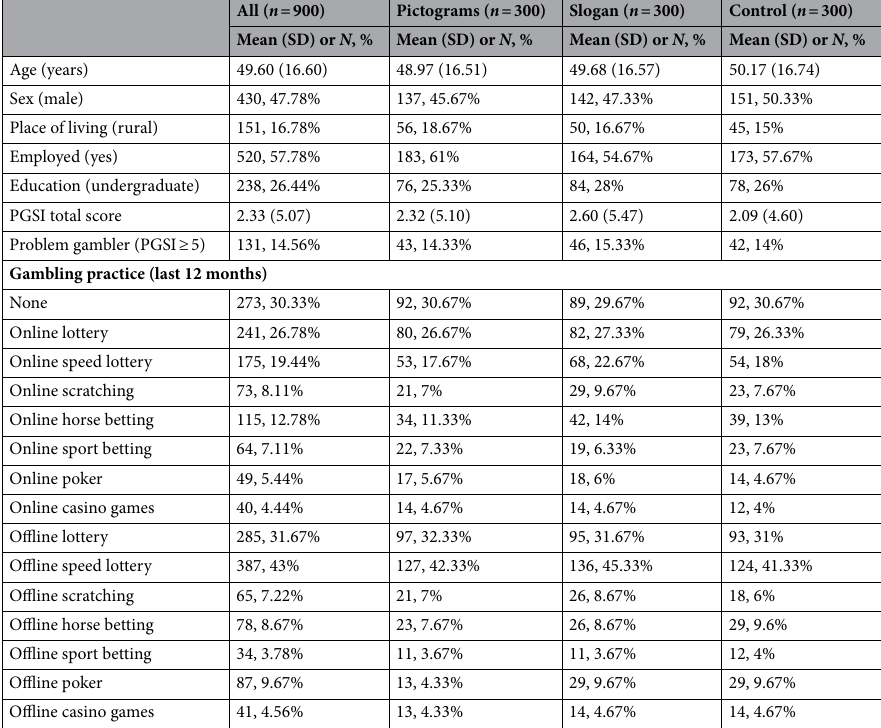
Table 2. Characteristics of the whole sample and by group (study in laypeople). PGSI problem gambling severity